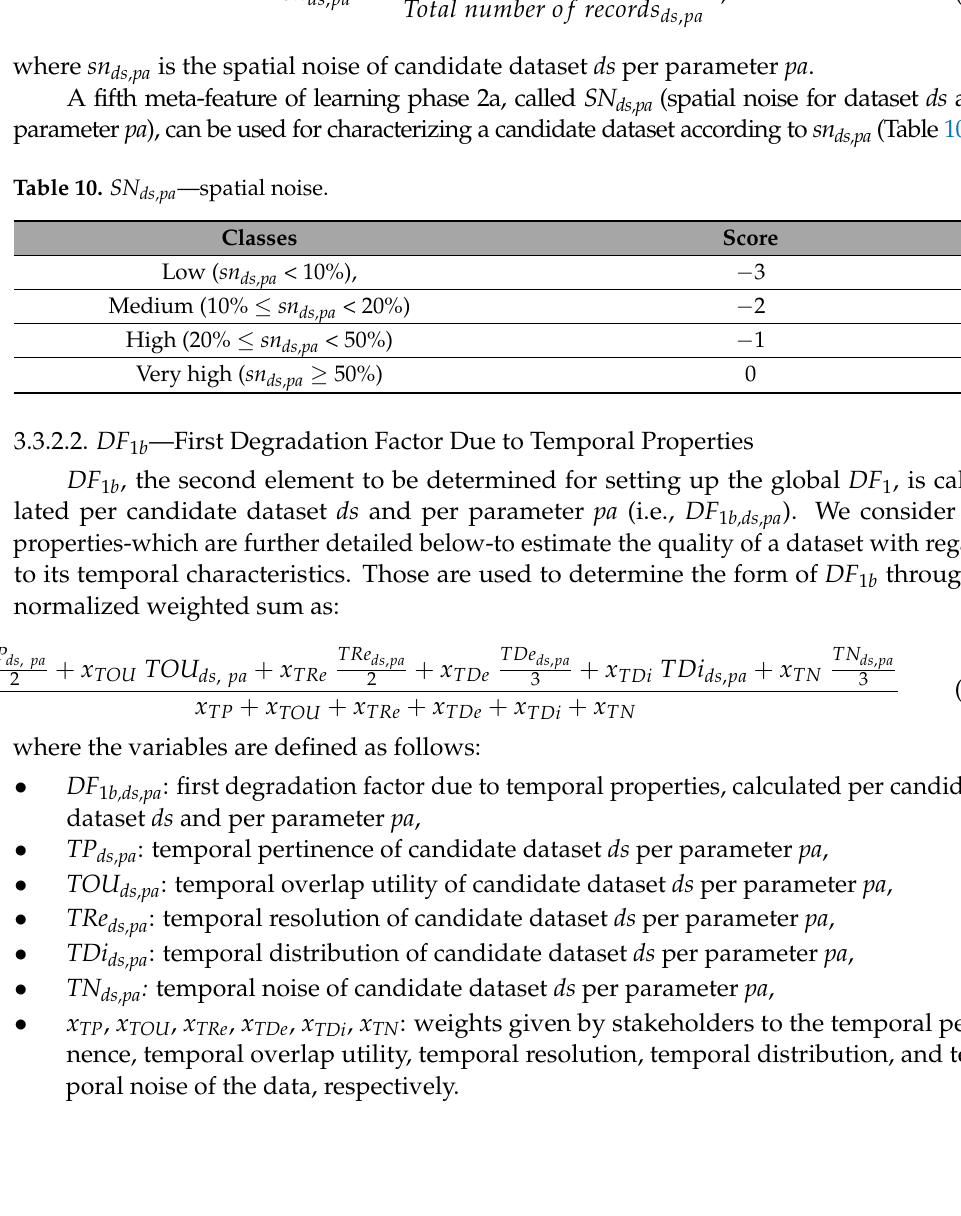
Property 2.5. Spatial Noise SN ds,pa